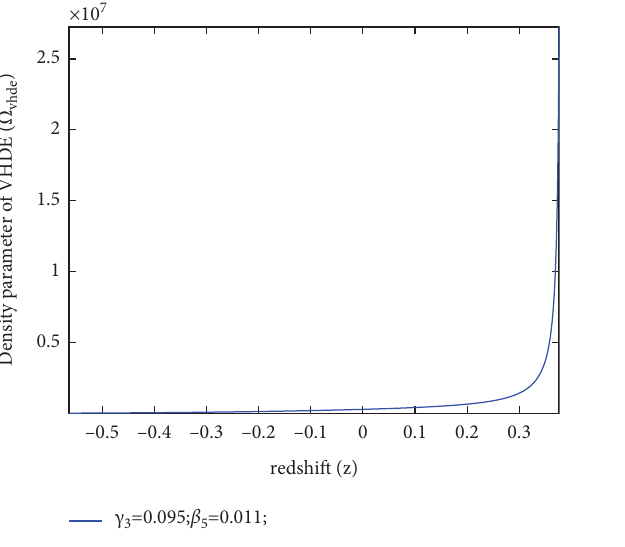
Figure 29: Om-diagnostics (Om( z )) versus redshift ( z ) for BT- vhde ) versus redshift ( z ) VIII.